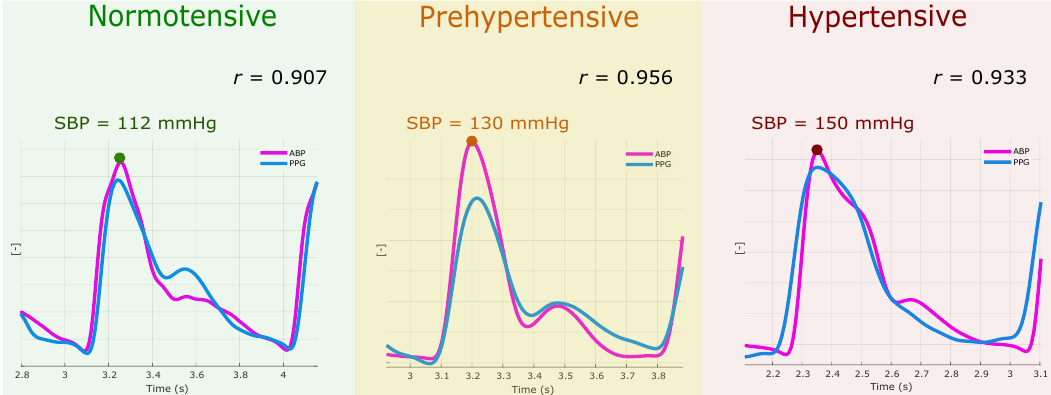
Figure 3. Examples of in-phase analysis. Note, r refers to the morphology correlation between photoplethysogram (PPG) and arterial blood pressure (ABP)